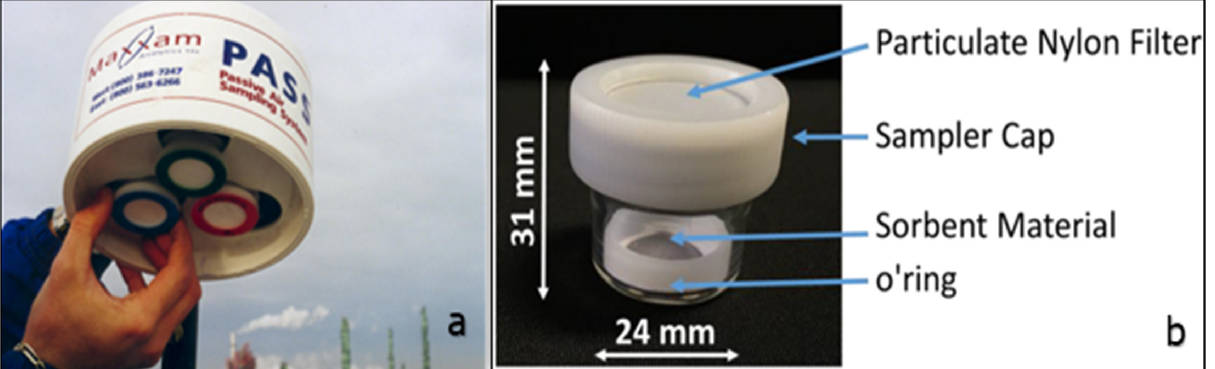
Figure 9. Field-used passive air samplers (PAS ( a )) [189], and passive sampler with nylon filter and the glass jar with the polytetrafluoroethylene (PTFE) ring inside ( b ) [190], with permission from Elsevier,